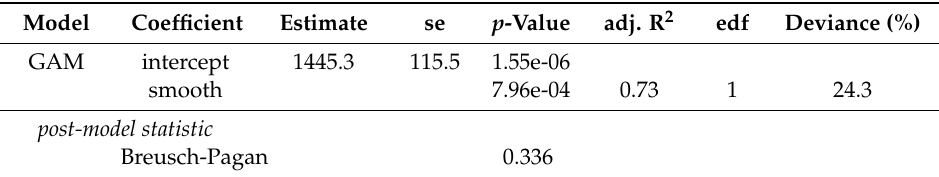
Table 2. Summary statistics of a generalised additive model (GAM) to predict AGB. The model is characterised by standard error (se), p -value at 95% confidence level and adjusted R 2 (adj. R 2 ). The spline function over the mean scattering angle is further explained by the estimated degrees of freedom (edf) and percentage of unexplained deviance in the model (deviance).